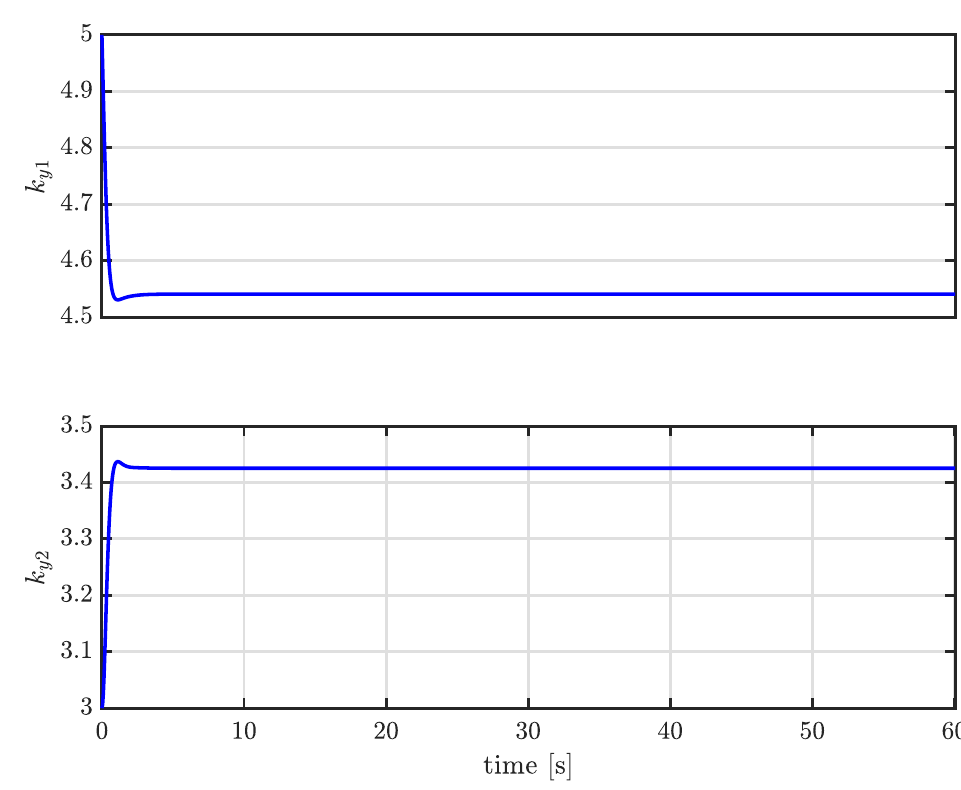
Figure 8. Control gains for pitch control (Case II-simulation).